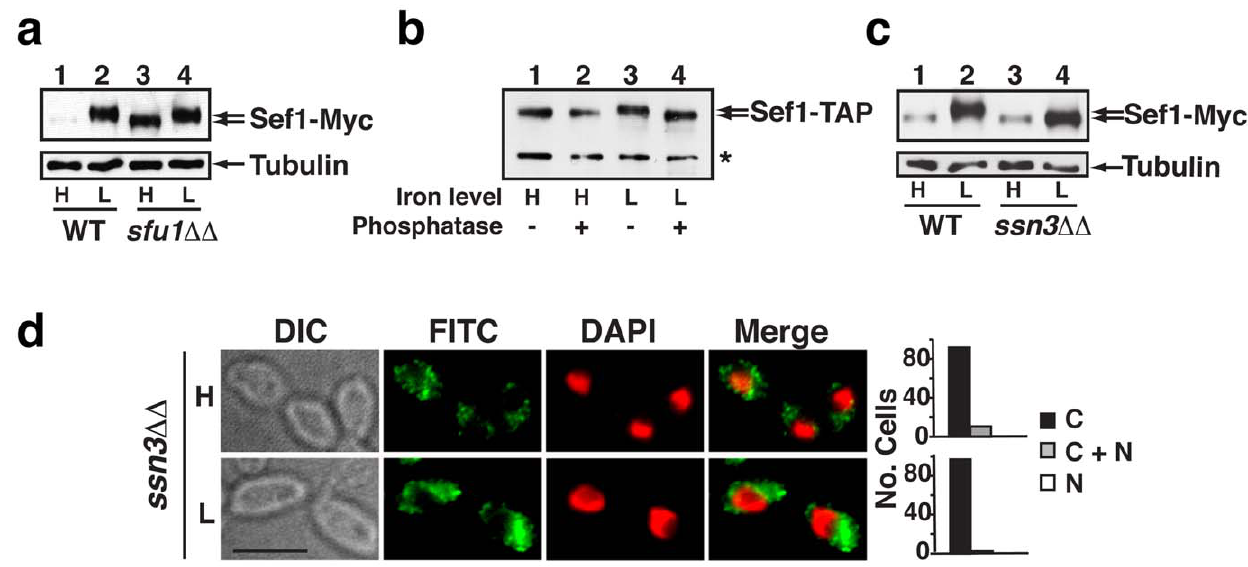
Figure 2. Ssn3 promotes phosphorylation and nuclear localization of Sef1 under iron-depleted conditions. a) Immunoblot of Sef1-Myc and alpha tubulin (internal standard) in wild-type vs. sfu1 DD cells propagated under iron-replete (H) or iron-depleted (L) conditions. B) Immunoblot of purified Sef1-TAP protein either treated ( + ) or not treated ( 2 ) with lambda phosphatase. To accumulate sufficient quantities of the higher mobility form of Sef1-TAP (lanes 1 and 2), the protein was purified from an sfu1 DD mutant grown under iron-replete conditions. The lower mobility form (lanes 3 and 4, prior to phosphatase treatment) was purified from wild-type cells grown under iron-depleted conditions. * indicates a presumed Sef1- Myc C-terminal proteolysis product that is observed only when Sef1 is recovered from nondenaturing extracts, such as those used for TAP purification; this fragment is not seen when denaturing extracts are used as in (a) above and (c) below. c) Immunoblot of Sef1-Myc and alpha tubulin recovered from wild-type or ssn3 DD cells under iron-replete or iron-depleted conditions. d) Indirect immunofluorescence of Sef1-Myc in the ssn3 DD mutant under iron-replete or iron-depleted conditions. Scale bar, 5 m m; all images obtained at the same magnification.